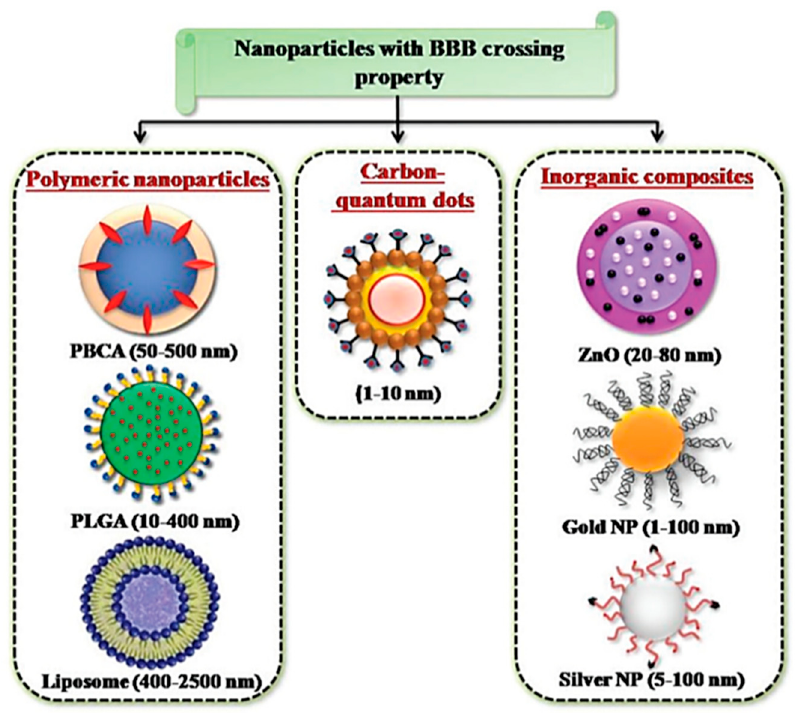
Figure 8. NPs developed for targeted drug delivery into the brain. Reproduced with permission from [58].